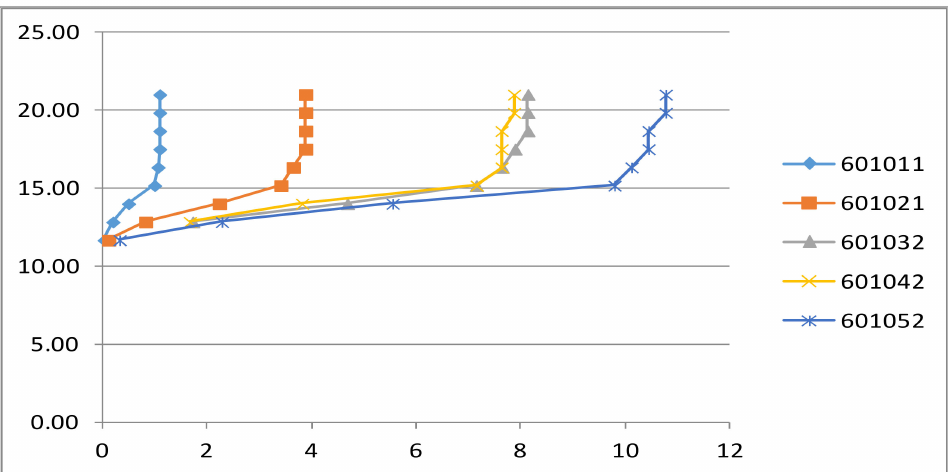
Figure 2. Supply curves of biomass for 5 LAU2 units (gminas) in Lubelskie (vertical axis in € /t, horizontal axis in kt)—601011: Miedzyrzec Podlaski, 601021: Terespol, 601032: Biala Podlaska, 601042: Drelow, 601052: Janow